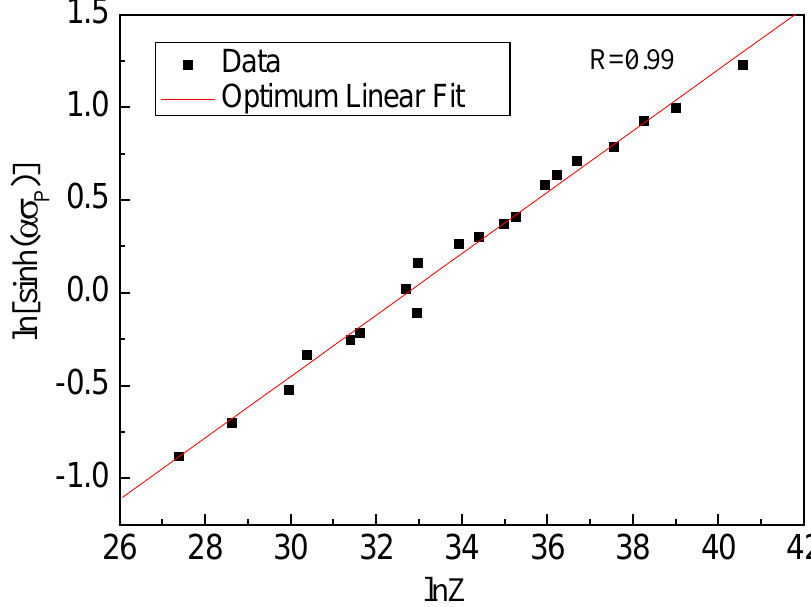
Figure 5. Relation between ln[sinh( ασ p )] and ln Z .